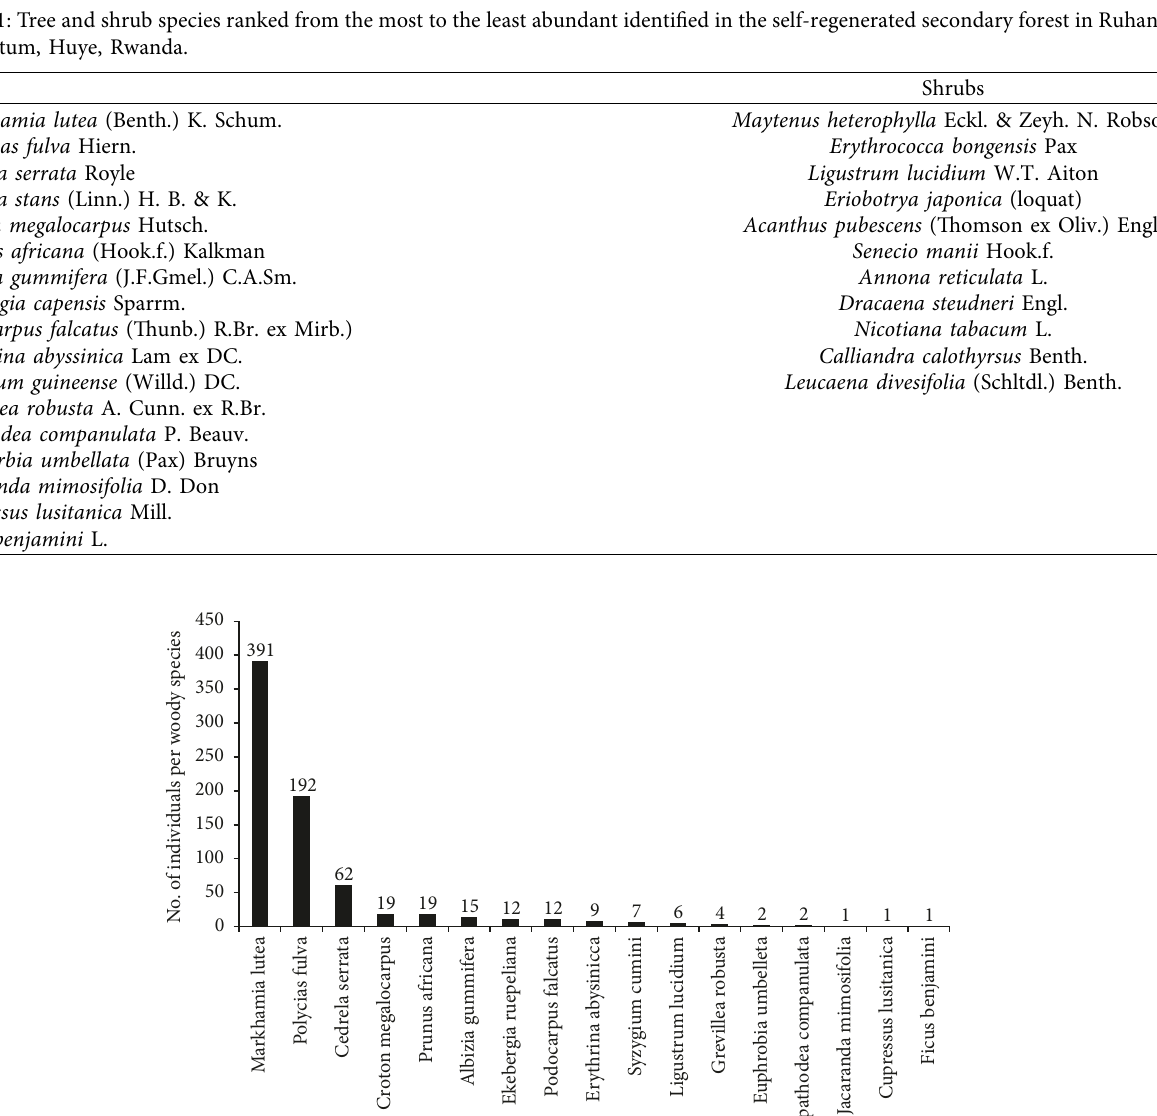
Figure 2: Number of individuals of tree species identified in the self-regenerated secondary forest in Ruhande Arboretum, Huye, Rwanda.